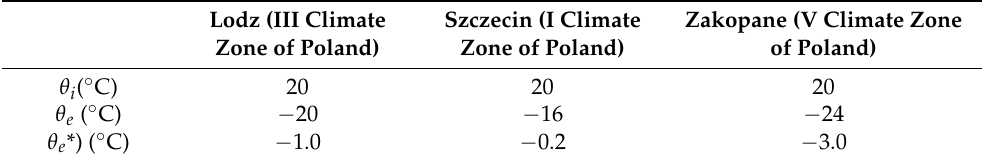
Table 8. Internal and external air temperature in the analyzed variants